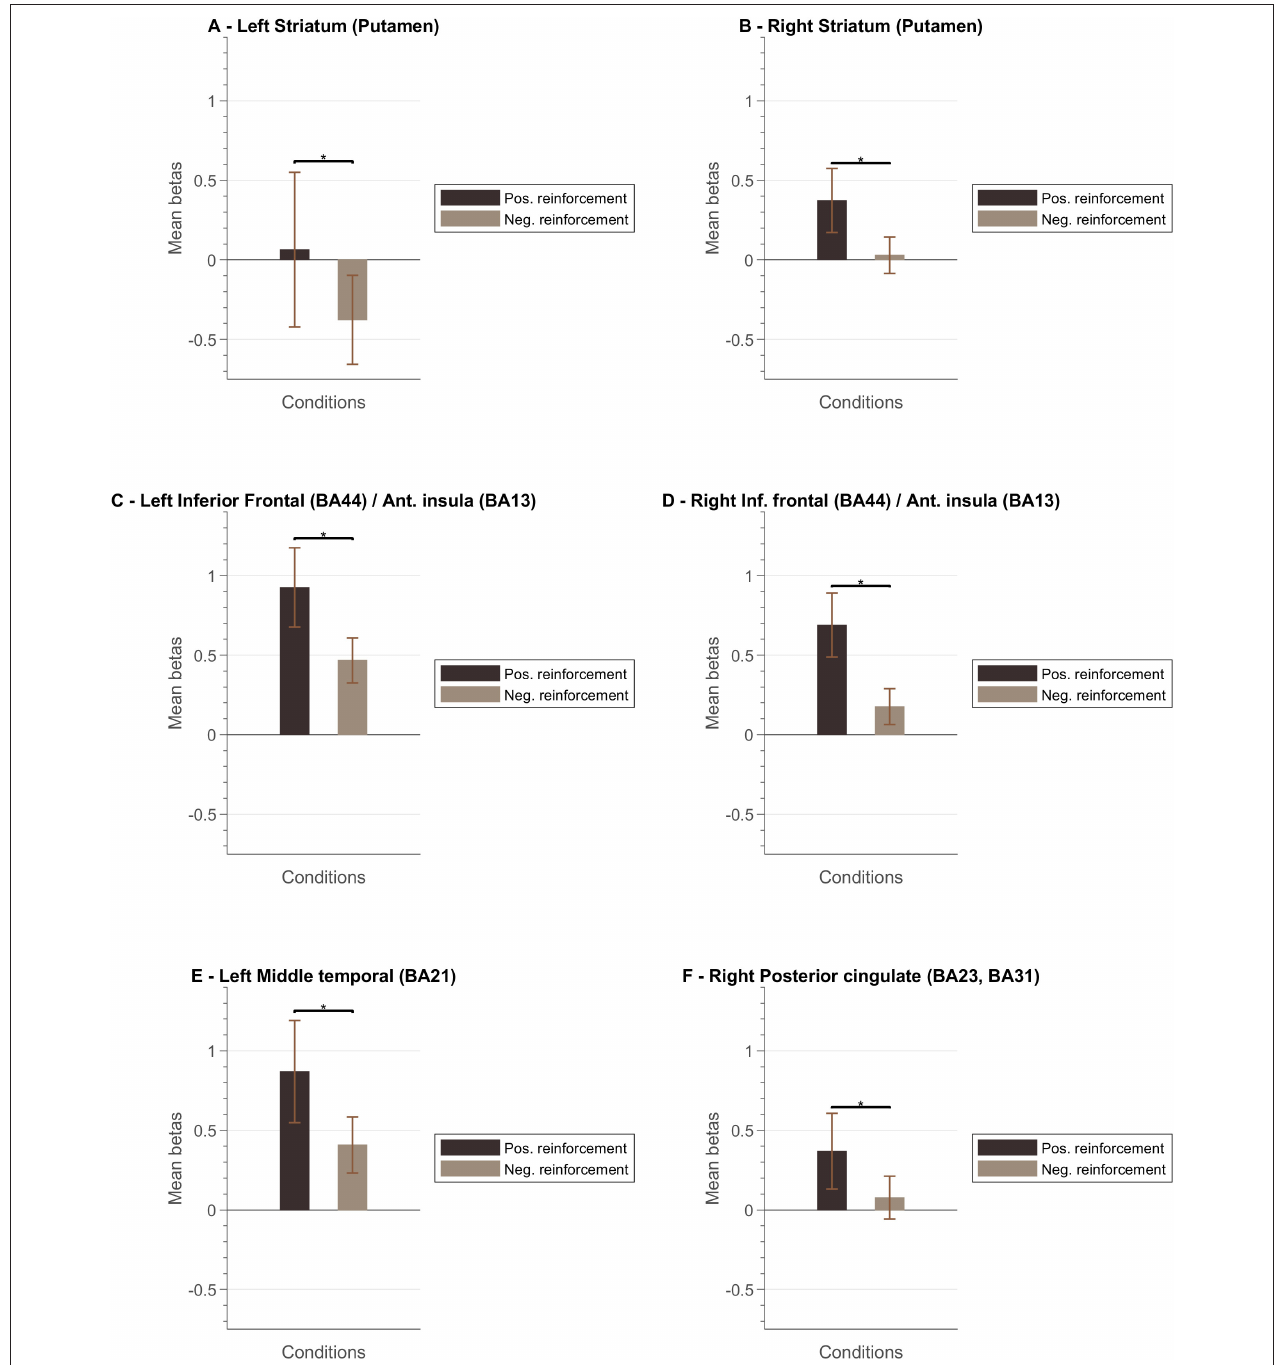
FIGURE 9 | Mean beta values per ROI. The left columns for each ROI correspond to the mean bata value associated to the “positive reinforcement” events and the right columns to the “negative reinforcement” events (the whiskers represent the SEM) for the following ROIs: (A) Left Striatum (Putamen); (B) Right Striatum (Putamen); (C) Left Inferior Frontal Cortex (Brodmann Area, BA, 44)/Anterior Insula (BA13); (D) Right Inferior Frontal Cortex (BA44)/Right Anterior Insula (BA13); (E) Left Middle Temporal Cortex (BA21); (F) Right Posterior Cingulate Cortex (BA23, BA31).